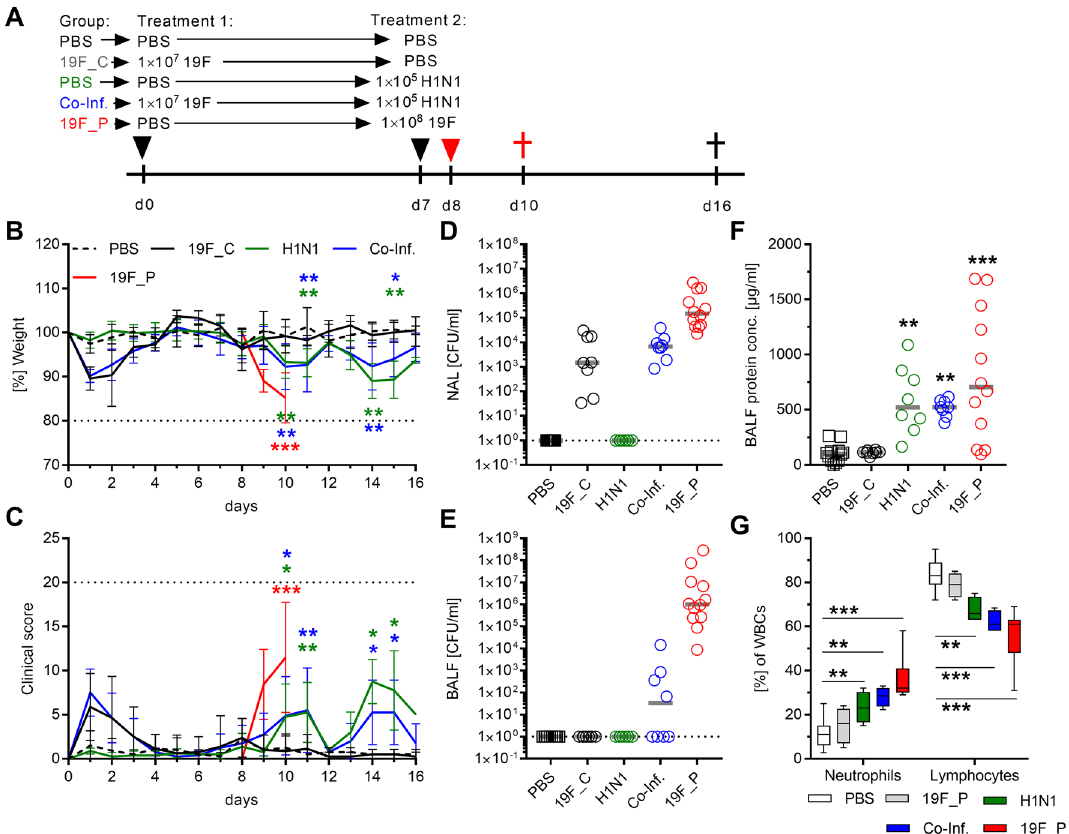
Figure 3. Mild H1N1 infection of S. pneumoniae 19F colonized mice does not result in severe co-infection. ( A ) Female C57BL/6J mice were intranasally colonized with S. pneumoniae 19F (1 × 10 7 CFU) for seven days followed by a subsequent mild H1N1 infection (1 × 10 5 PFU; Co-Inf.). PBS challenged (PBS), only colonized (19F_C), and only H1N1 infected (H1N1) mice served as controls. In addition, severe pneumococcal pneumonia was induced via intranasal inoculation of S. pneumoniae 19F (1 × 10 8 CFU; 19F_P; day 8). ( B ) Weight and ( C ) clinical score were monitored over a period of 16 consecutive days. Horizontal dotted lines in B and C indicate termination conditions (20% weight loss and/or clinical score of 20) of the experiment. ( D ) CFU counts in nasal washes (NAL) and ( E ) in BALF, ( F ) protein concentration of the BALF and ( G ) WBC were determined after the animals were sacrificed. Horizontal dotted lines in ( D ) and ( E ) indicate the limit of detection. Animals were sacrificed at day 16 except for the pneumonia group which was sacrificed at day ten. Two independent experiments with four to six mice per group (total: n ≥ 8) were performed. In general, mean values ± SD are displayed ( B , C ). Each dot represents one mouse and horizontal lines display mean values ( D – F ). The data in ( G ) are displayed as box plots. The level of significance between the PBS and all other groups was determined using Kruskal Wallis test with Dunn’s multiple comparison post-test (* p < 0.05; ** p < 0.01; *** p <